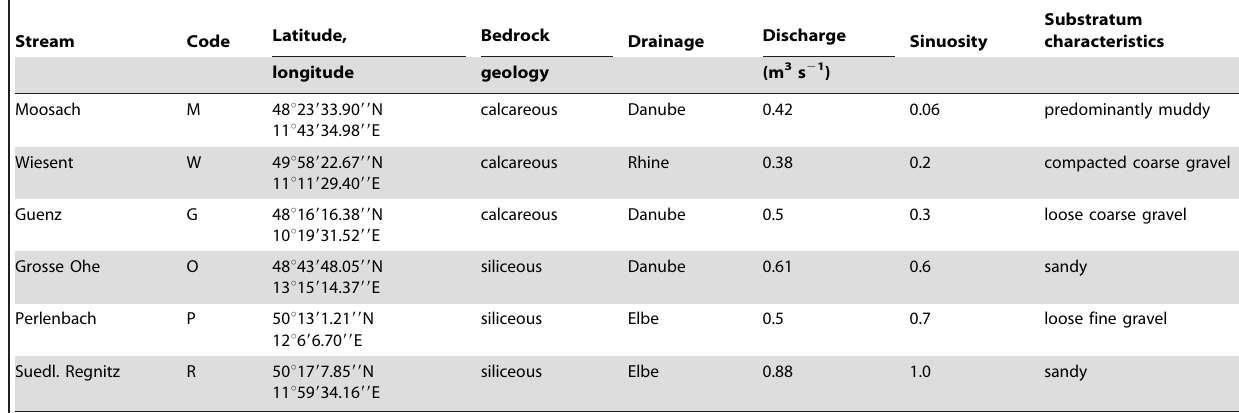
Characteristics of the investigated stream reaches: code, geographical position (latitude, longitude), associated bedrock geology (calcareous or siliceous), drainage system, mean annual discharge, sinuosity calculated for 1.5 km linear distance upstream of the investigated stream reach, and substratum characteristics.